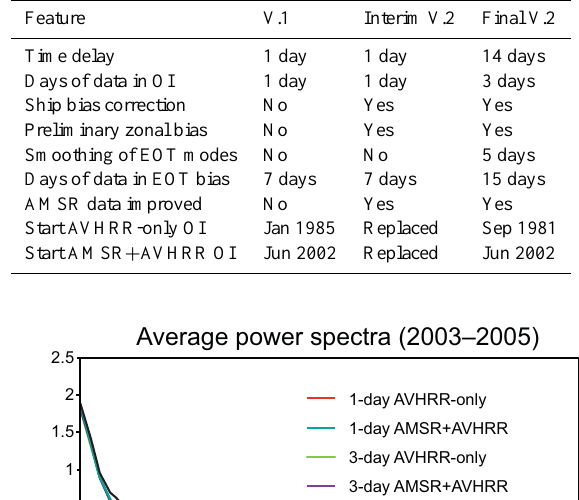
Table A1. The linear least squares fit of the ship and buoy data shown in Fig. A2.